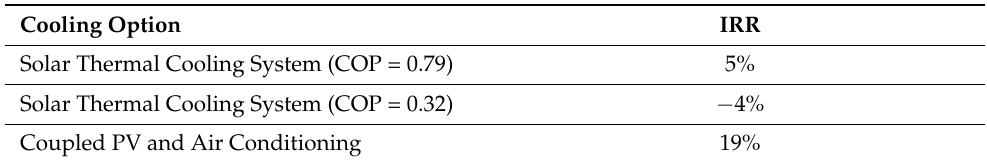
Table 1. Internal rate of return (IRR) for different cooling systems. Cooling